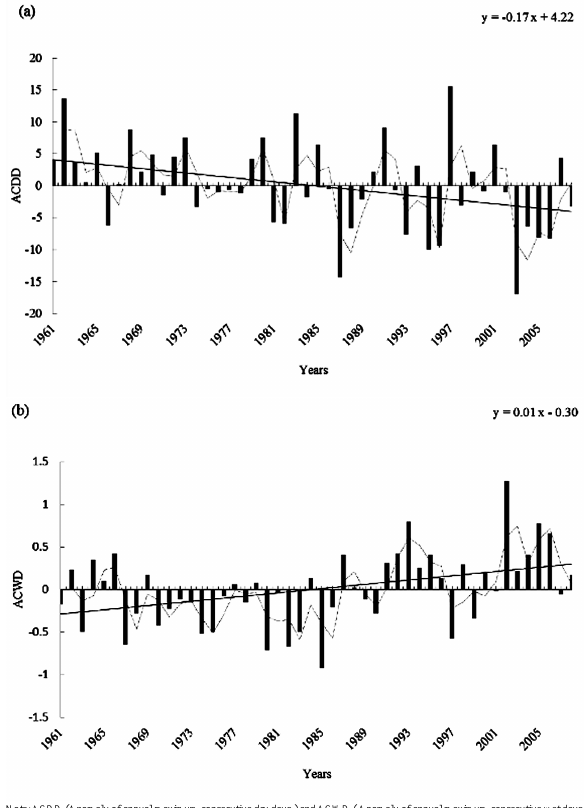
Figure 3 Fig. 3. Changes of CWD and CDD anomalies over Xinjiang from 1961 to 2008: (a) Anomalies of CDD; (b) anomalies of CWD. Note: ACDD (Anomaly of annual maximum consecutive dry days) and ACWD (Anomaly of annual maximum consecutive wet